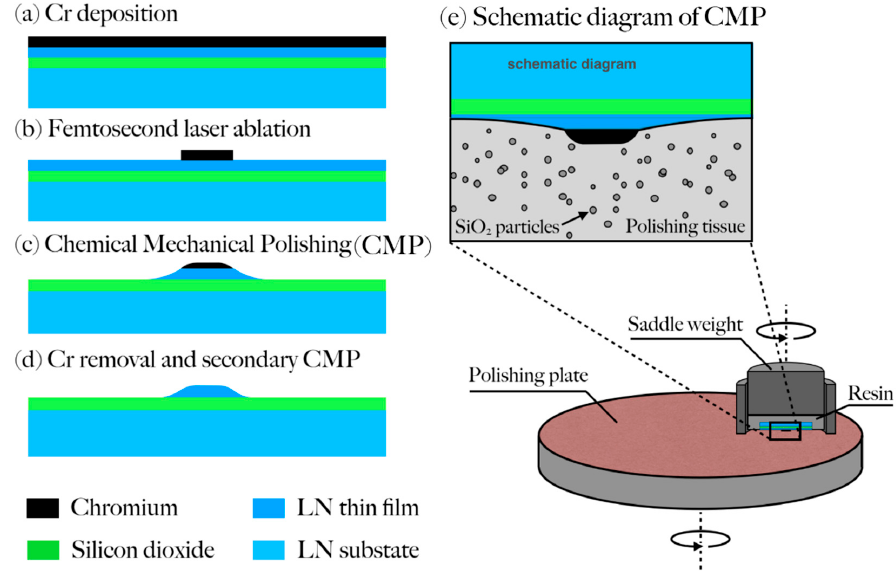
Figure 1. ( a – d ) Flow-chart of fabrication of lithium niobate on insulator (LNOI) waveguide and ( e ) schematic diagram of chemo-mechanical polishing (CMP).